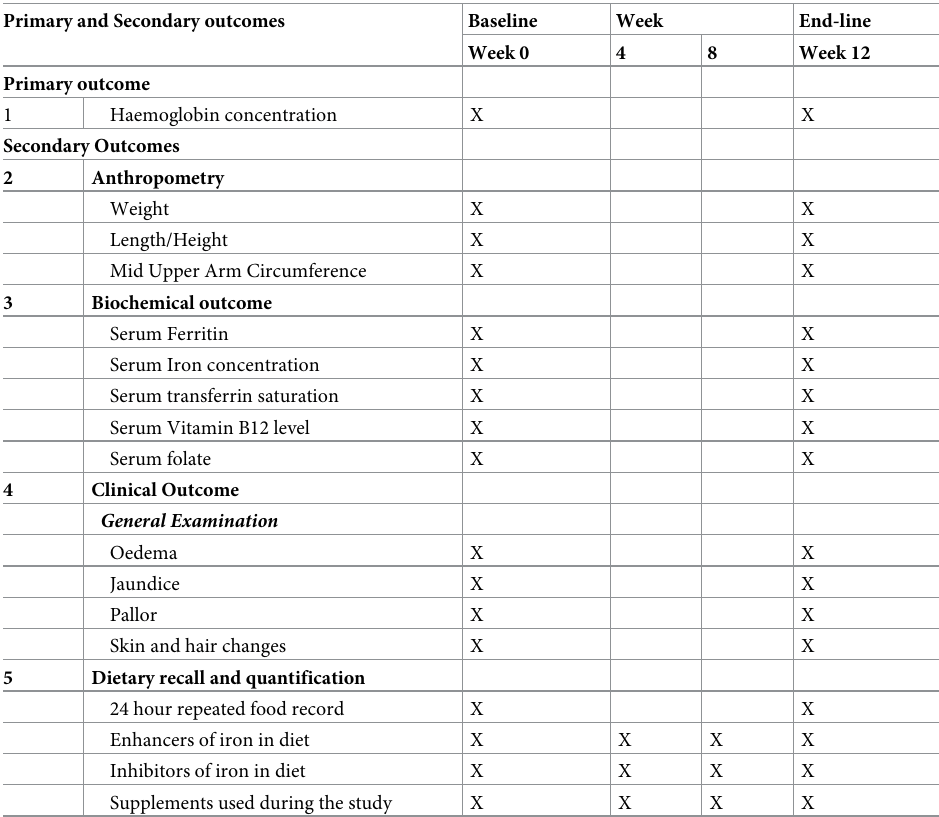
Table 1. Baseline and Outcome measures, intermediary factors and time